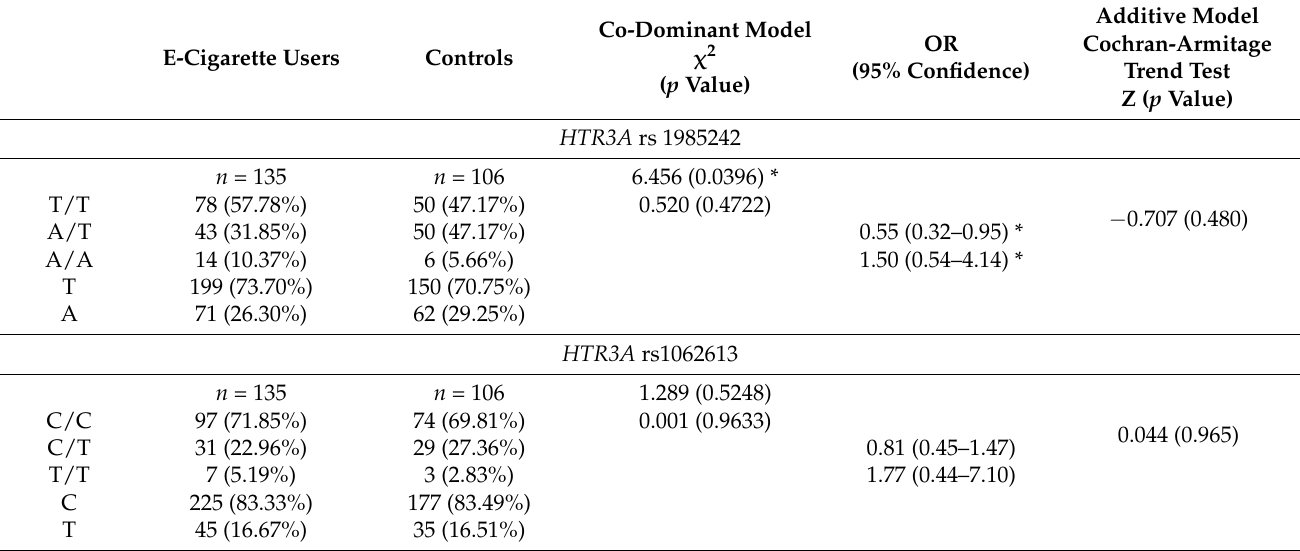
Table 2. Frequencies of genotypes and alleles of HTR3A rs1985242 and rs1062613 in the group of e-cigarette users and